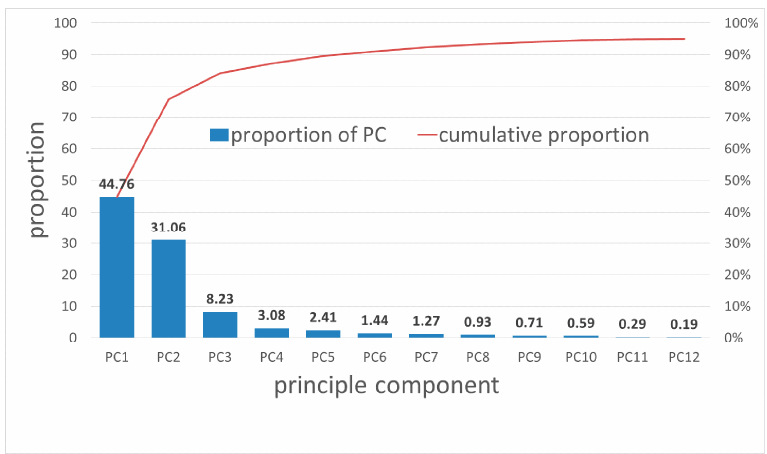
Figure 4. Cumulative variance of the first 12 principal components.